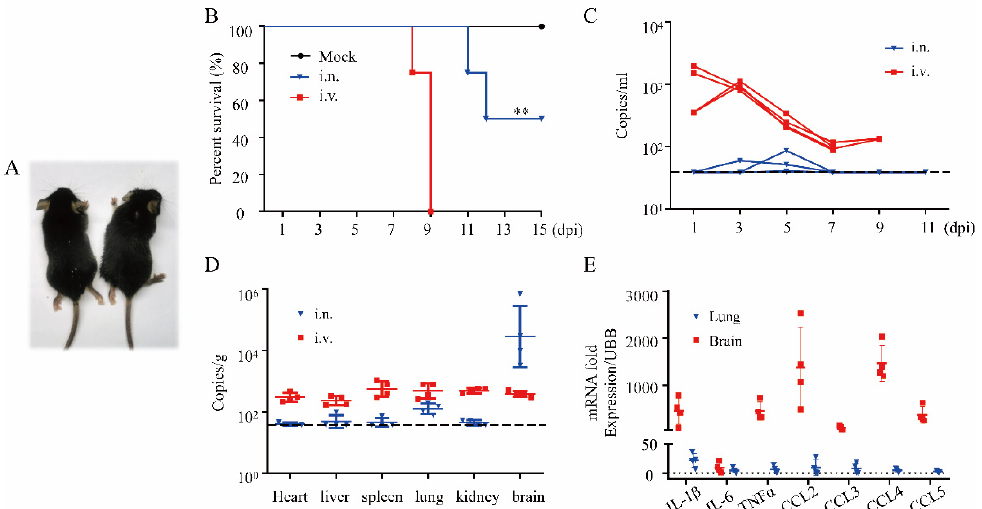
Figure 5. DENV-2 infection via the intranasal route is lethal in A6 mice. ( A ) Representative images of intranasally challenged A6 mice with neurological symptoms. ( B ) Survival probability of DENV-2 challenged A6 mice administered the virus via the intravenous or intranasal routes. Survival conditions were monitored daily after challenge (titer = 2.4 × 10 5 PFU; i.v., n = 4; i.n., n = 4; mock, n = 4). **, p < 0.01. ( C ) Viremia in A6 mice after DENV-2 inoculation. (i.v., n = 4; i.n., n = 4). Dotted lines indicate the limits of detection. ( D ) Internal organ samples were harvested, and the virus titer was evaluated (i.v., n = 4; i.n., n = 4). ( E ) Expression of pro-inflammatory factors in the brains and lungs of moribund A6 mice. Abbreviations: i.v., intravenous; i.n., intranasal; dpi, day post inoculation.